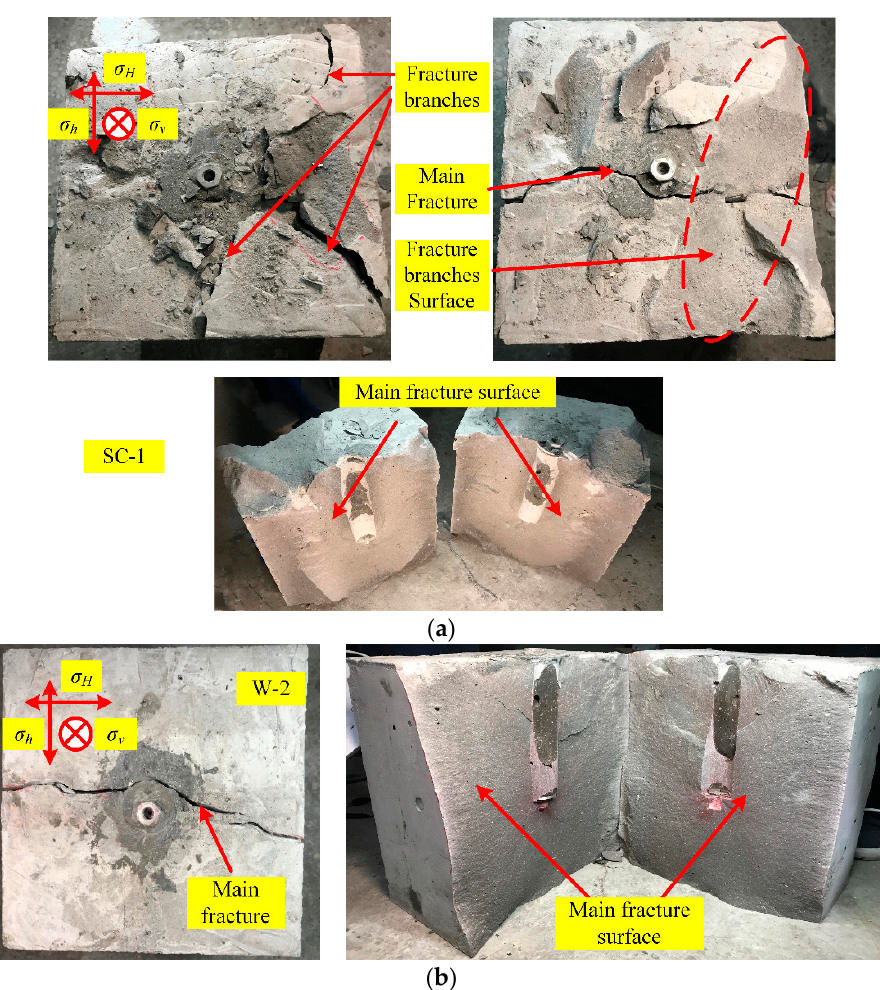
Figure 5. Comparison of fracture propagation and morphology in artificial sandstone between SC-CO 2 induced fractures and water induced fractures. ( a ) SC-1: Artificial sandstone fractured by SC-CO 2 . The upper broken rocks are being removed from the top left to right images; ( b ) W-2: Artificial sandstone fractured by water.